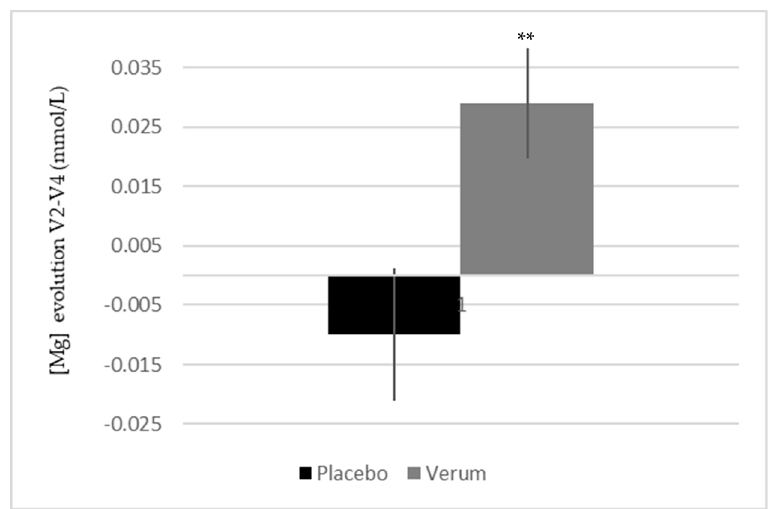
Figure 8. Influence of melon concentrate supplementation on the magnesium plasma concentration. Results are expressed as [Mg] (mmol/L) ± SEM. ** p < 0.01 effect of the melon concentrate supplementation compared with placebo group.